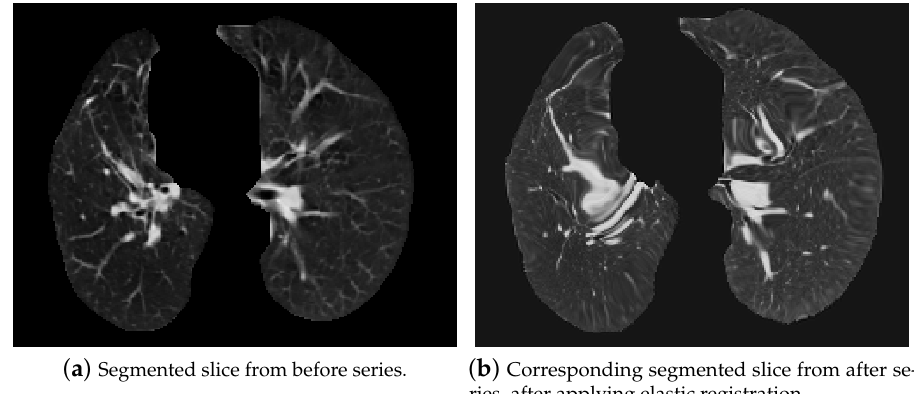
Figure 20. Illustration of the elastic registration using the SimpleElastix library.